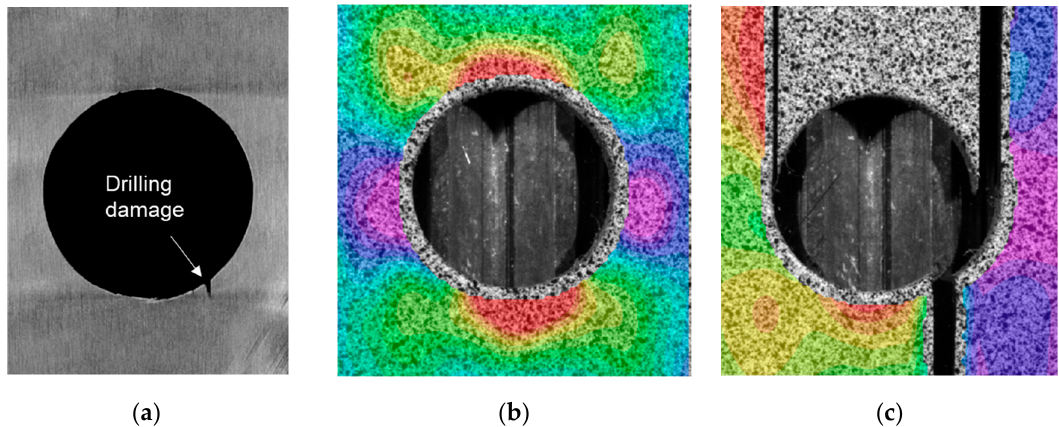
Figure 19. ( a ) Cross-sectional CT data prior to testing, ( b ) DIC-measured ILT strain distribution and ( c ) failure mode in a unidirectional tape specimen with non-acceptable failure mode due to the effects of drilling damage.